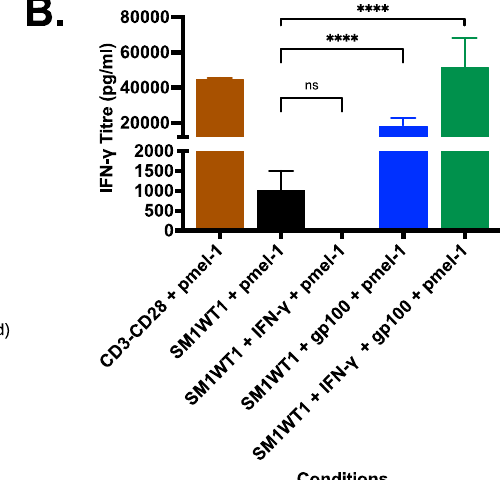
Figure 4. SM1WT1 tumor response to targeted and ACT. ( A ) Chromium release assay of MC38 and SM1WT1 vs. pmel-1 (mean ± SEM of 3 independent experiments). ( B ) SM1WT1-pmel-1 IFN- γ Release Assay (mean ± SEM of 3 independent experiments). SM1WT1 + pmel-1 were incubated for 16 h. To ensure MHC Class I expression, SM1WT1 cells were also pre- incubated with IFN- γ (2 ng/mL) for 24 h and washed twice prior to incubation with pmel-1 (SM1WT1 + IFN- γ + pmel-1). SM1WT1 was pulsed with gp100 peptide (1 ng/mL) for 30 min and washed twice prior to incubation with pmel-1 (SM1WT1 + gp100 + pmel-1). * p < 0.05, **** p <